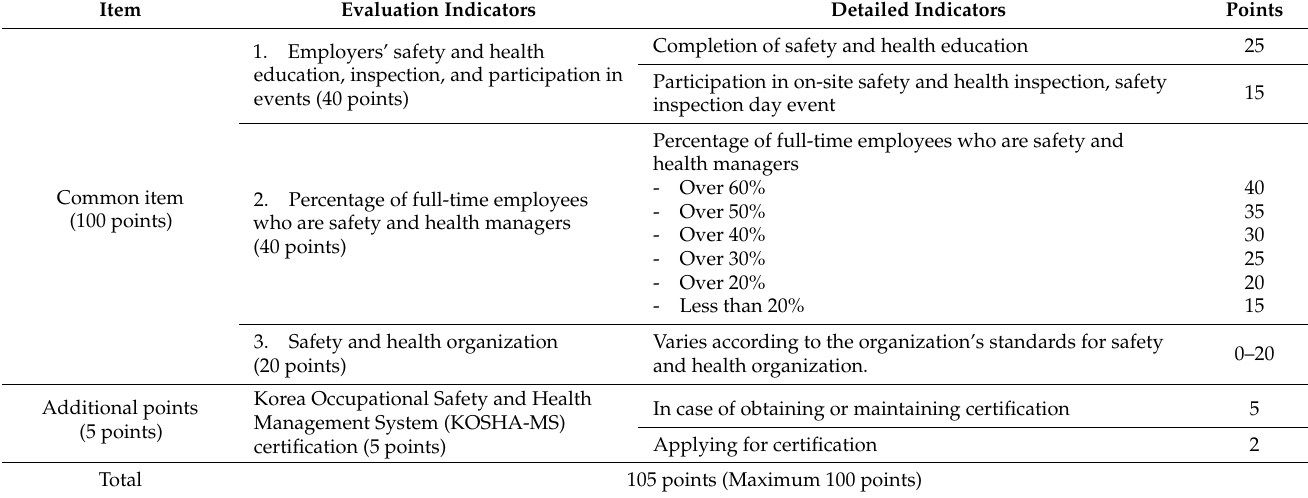
Table 2. Construction companies with construction sites where are obligated to appoint a safety and health manager (Type